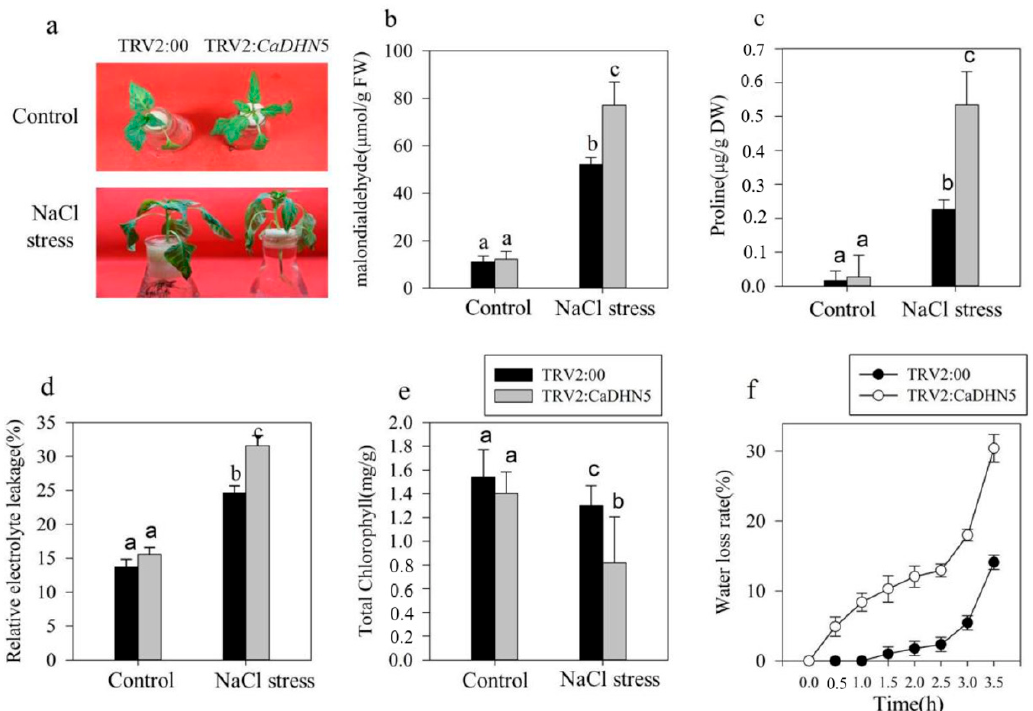
Figure 4. Effects of salt stress on plant phenotypes. ( a ) The phenotype of CaDHN5 -silenced pepper plants under NaCl treatment; ( b ) MDA content; ( c ) proline levels; ( d ) relative electrolytic leakage; ( e ) total chlorophyll content; ( f ) water loss. Data that are significantly different are indicated with letters above the error bars (±S.D.). The different letters with the bars indicate significant differences as determined using Tukey HSD’s multiple range tests ( p < 0.05).